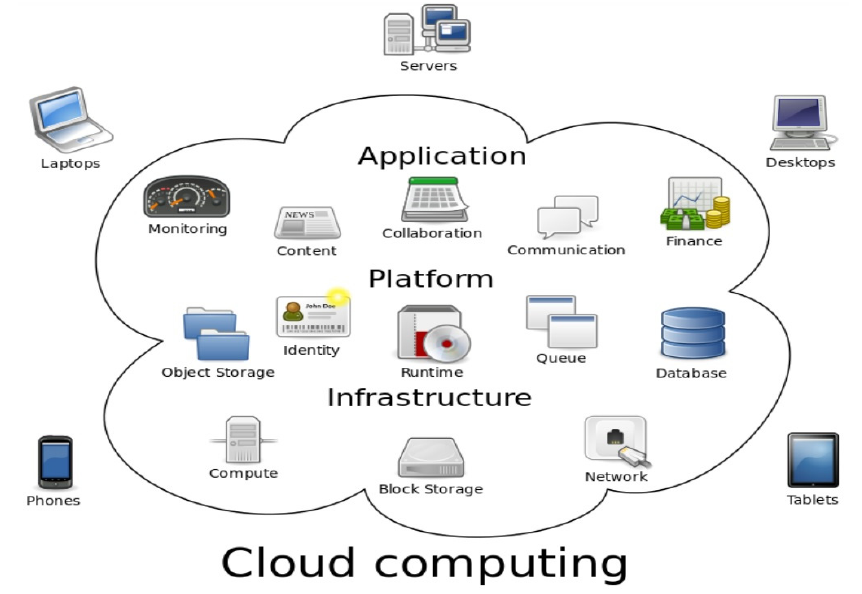
Figure 1. Cloud Computing Environment [14].